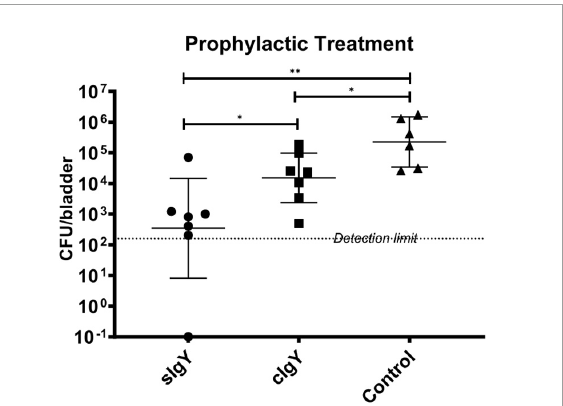
FIGURE4 Prophylactic treatment with both specific and control IgY reduces bladder bacteriology in vivo . A bacterial overnight culture of PAO1 was adjusted to 2 × 10 7 CFU/mL in saline. sIgY and cIgY were diluted to reach 40% in saline. Twenty-seven 10-week-old female Balb/c mice were randomized into the three groups, anesthetized, and 25 µ L of IgY was installed intravesically. After 30 min, 25 µ L of the bacterial solution was injected intravesically. The mice were observed for another 30 min after infection to exclude mice that were voiding during this period. Twenty hours after infection, all mice were euthanized. Blood, kidneys, and bladders were harvested. The organs were homogenized and quantitative bacteriology was evaluated the next day. Displayed are the CFU (geometric mean with 95% confidence interval) detected in the bladders of all not excluded mice. Statistically significant differences were evaluated by Mann–Whitney tests ( ∗ p ≤ 0.05, ∗∗ p ≤ 0.01). TABLE 1 Pseudomonas aeruginosa PAO1 infection increases inflammatory cytokines in bladder.